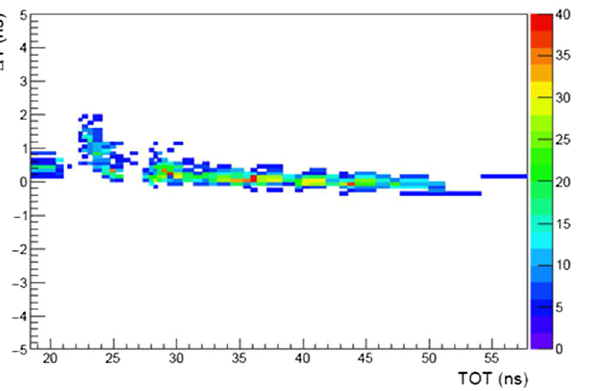
Fig. 21 Typical MRPC time vs TOT slewing correlation